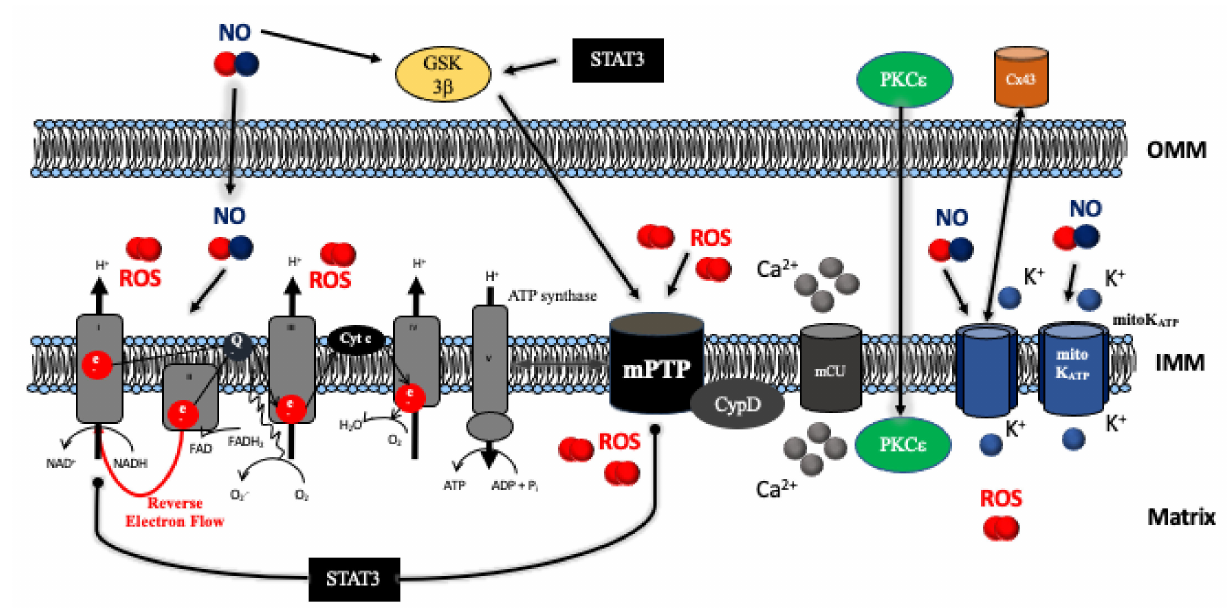
Figure 2. Molecular mechanisms of ischemia/reperfusion injury and cardioprotection acting onto the mitochondria. Diverse intracellular signaling pathways including the RISK (Erk1/2, Akt) and SAFE pathways (Jak) target mitochondrial functions. The centerpiece of cardioprotection is the preservation of mitochondrial respiratory function verhindern massive reactive oxygen species (ROS) production, Ca 2+ overload, and subsequent opening of the mitochondrial permeability transition pore (mPT). Abbreviations: Akt = protein kinase B; Cx43 = connexin 43; CypD = cyclophilin D; Erk1/2 = extracellular regulated kinase 1 and 2; GSK3 β = glycogen synthase kinase 3 β ; IMM = inner mitochondrial membrane; Jak = Janus-activated kinase; OMM = outer mitochondrial membrane; NO = nitric oxide; PKC ε = protein kinase C ε ; RISK = reperfusion injury salvage kinase; SAFE = survival activating factor enhancement; STAT3 = signal transducer and activator of transcription